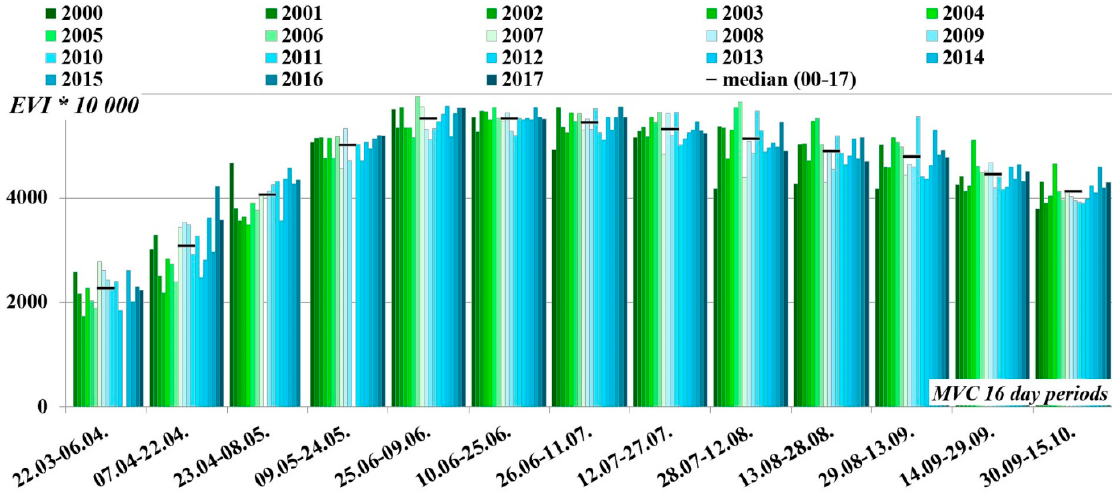
Figure 5. Deciduous forest EVI median value dataset in the MVC 16-day periods between 2000 and and 2017.